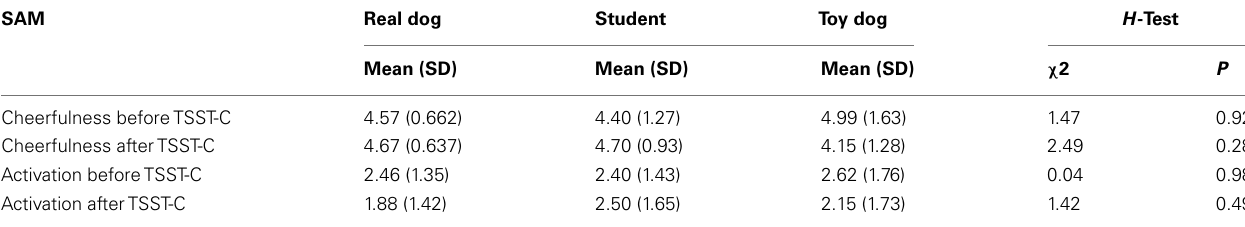
Table 3 | Mean values of SAM-subscales before and after theTSST-C, Kruskal–Wallis H -Test (df = 2). SAM Real